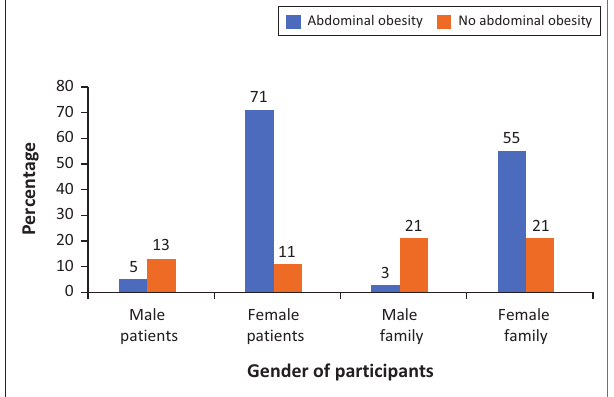
FIGURE 3: Waist circumference of participants by TABLE 3: Waist circumference by sociodemographic profile of respondents. Sociodemographic profile